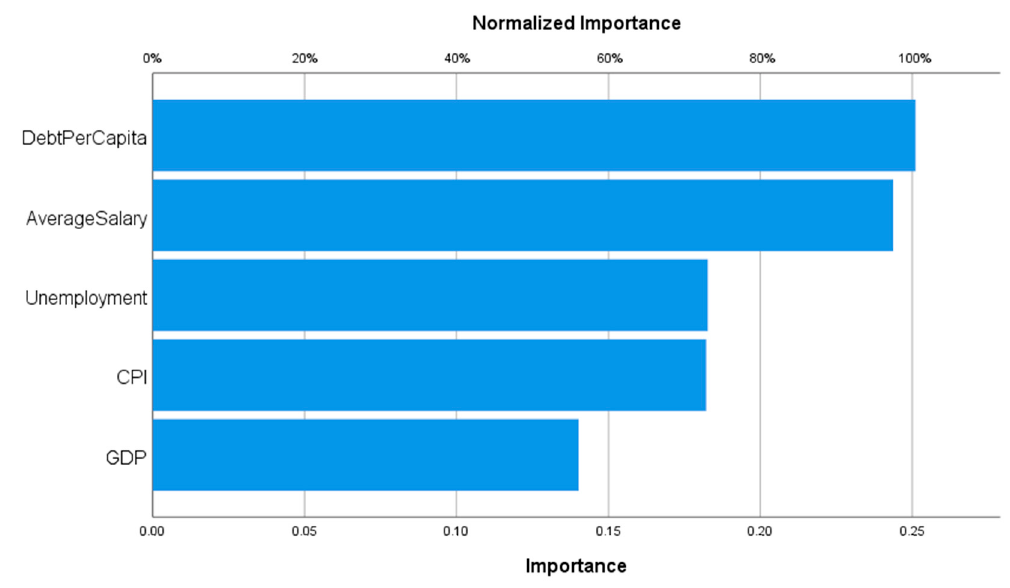
Figure 6. Standardized Importance of independent variables for Value.